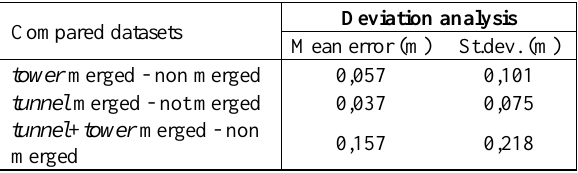
Table 4. Deviation analysis with merge